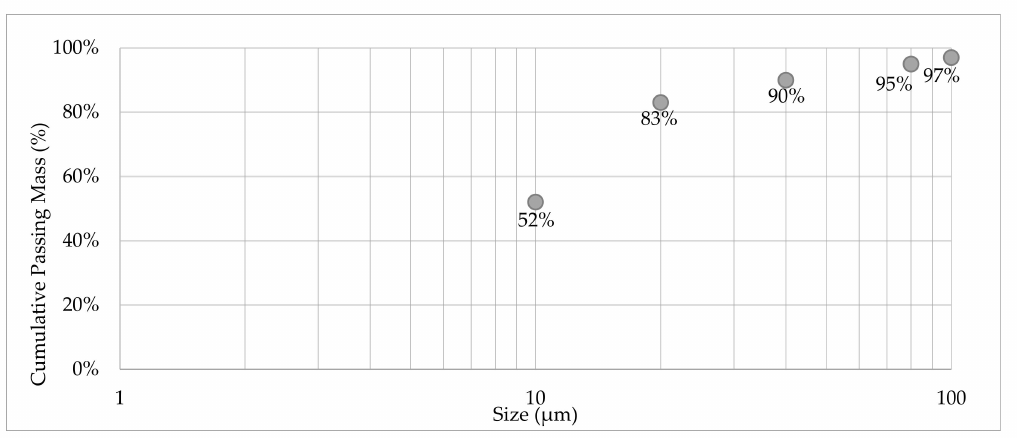
Figure 3. Particle size distribution of the slime